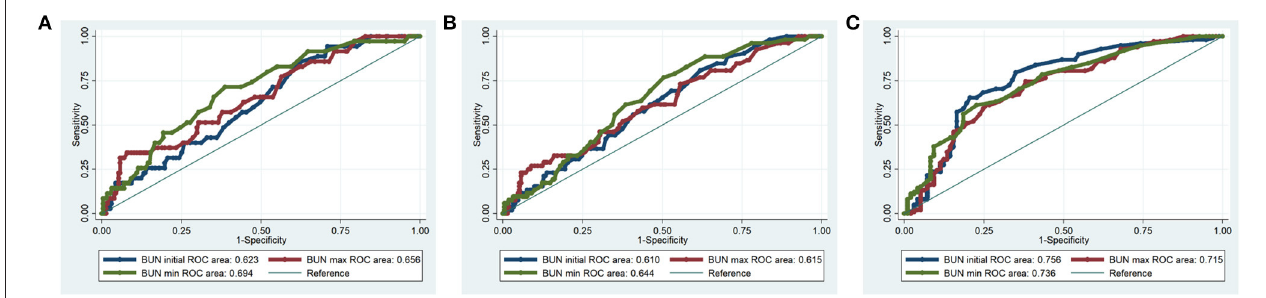
FIGURE 2 | ROC curves for BUN in hospital mortality, 90-day mortality and 4-year mortality of the PPH patients. (A) Hospital mortality; (B) 90-day mortality; (C) 4-year mortality.